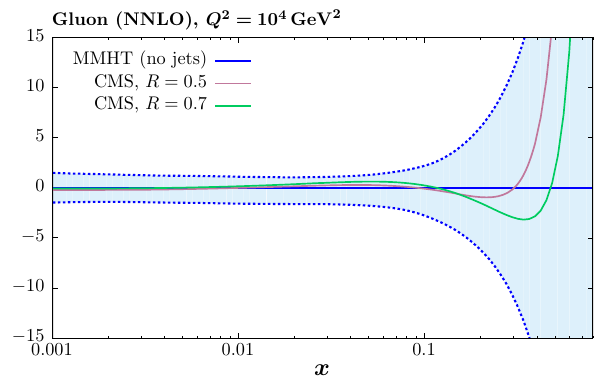
Fig. 6 The impact on the gluon PDF at NNLO of the CMS 7 TeV jet data [24], for two value of jet radii. The percentage difference in comparison to the baseline fit, with no jet data included, is shown